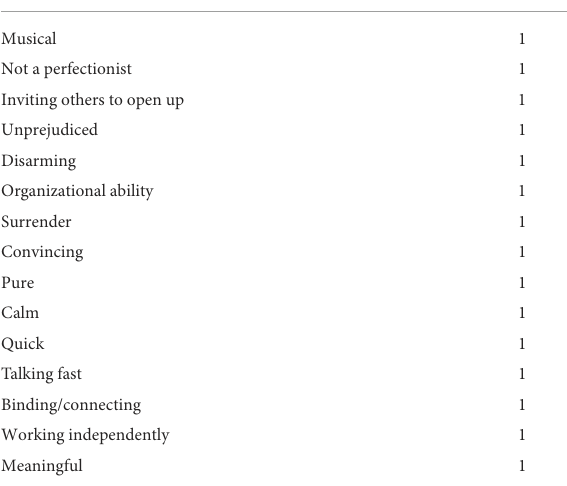
TABLE 2 List of low frequency codes excluded from the qualitative